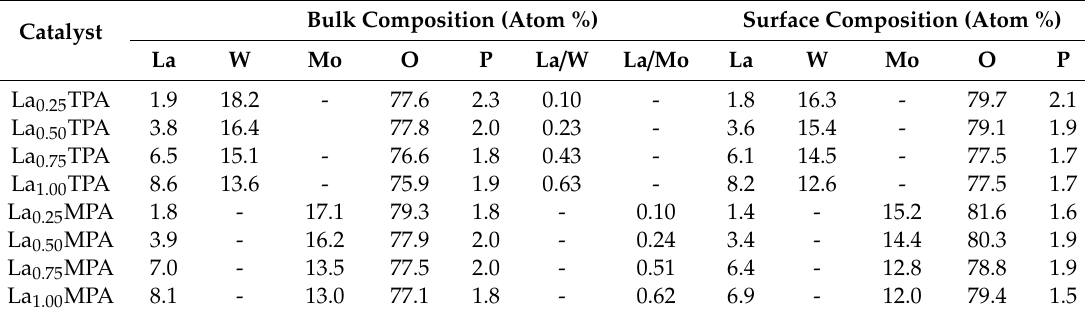
Table 2. Bulk and surface elemental composition of La exchanged TPA and MPA samples. Bulk Composition (Atom %) Surface Composition (Atom Catalyst